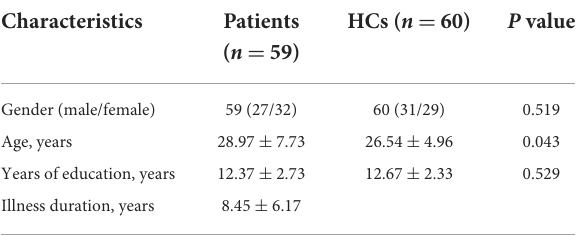
TABLE 1 The clinical properties of patients and healthy controls.